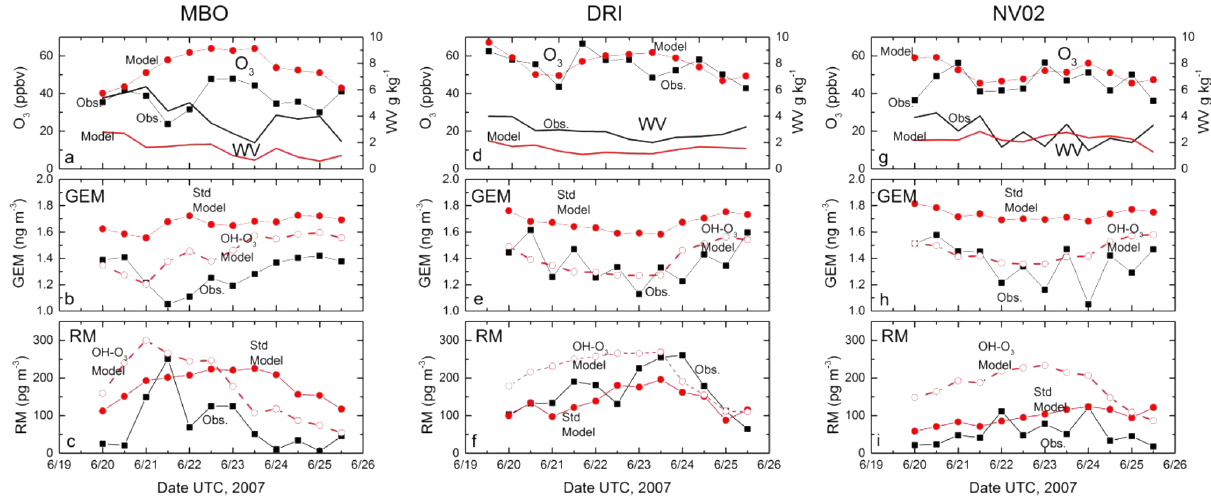
Figure 4. (a–i) : The twelveh mean concentrations of O 3 , water vapor, GEM, and RM at three sites during a high-RM event from 20 to 25 June 2007. Observational, standard model, and OH–O 3 model data are